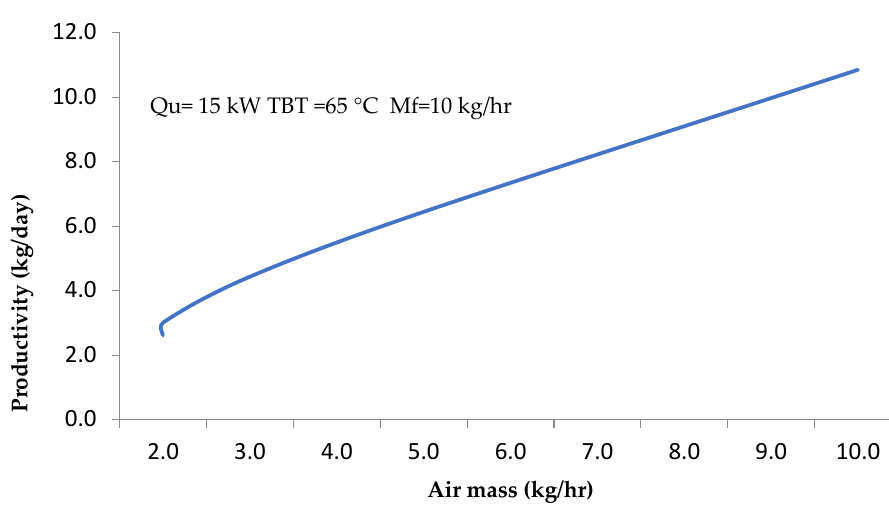
Figure 8. Effect of the feed water flow rate on the distillate production, Qu = 15 kW.